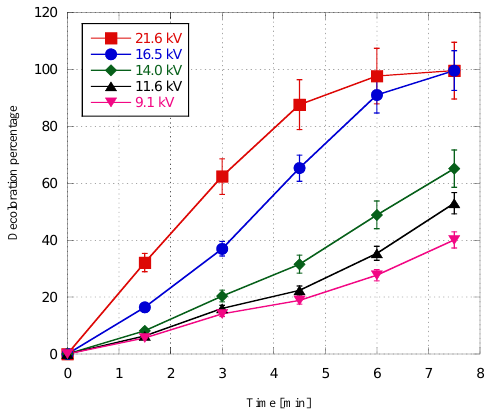
Figure 10. Decoloration percentage of indigo carmine dye solution at different input voltage of streamer discharge at the water surface.